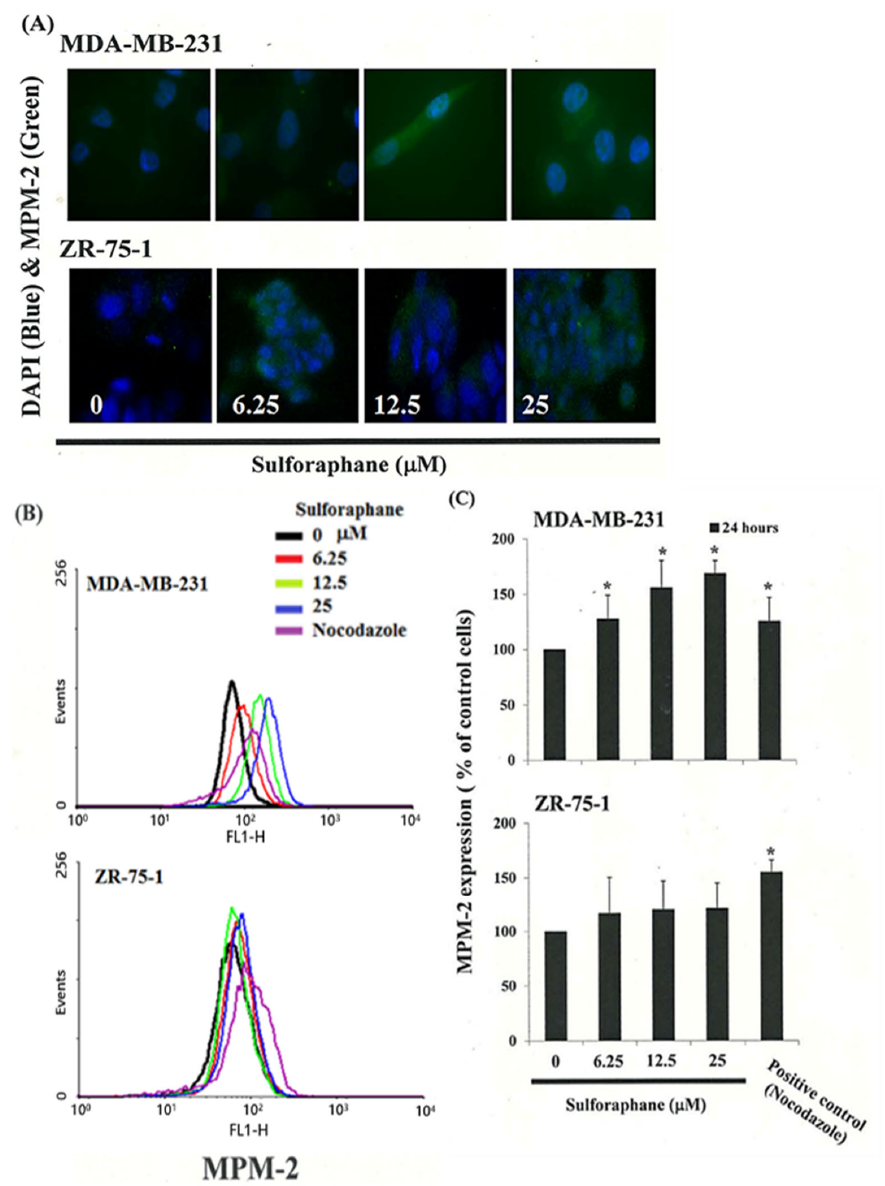
Figure 2. Diminished MPM-2 activity in SFN-treated MDA-MB-231 and ZR-75-1 cells. The MPM-2 activity of the cells was examined through confocal microscopy and flow cytometry 24 h after SFN stimulation. ( A ) The cells were stained for MPM-2 (green). DAPI (blue) stained nuclei with the active form of MPM-2. ( B ) Quantification of MPM-2 expression (gated cells) was performed by flow cytometry following treatment with SFN for 24 h. ( C ) SFN increased the level of MPM-2 in those cells. As a positive control, separate groups of cells were treated for 24 h with Nocodazole (15 µg/mL), an antifungal agent that induces metaphase arrest. * in each group of bars indicates that the di ff erence resulting from treatment with 0 ìM SFN was signi fi cant at p < 0.05.